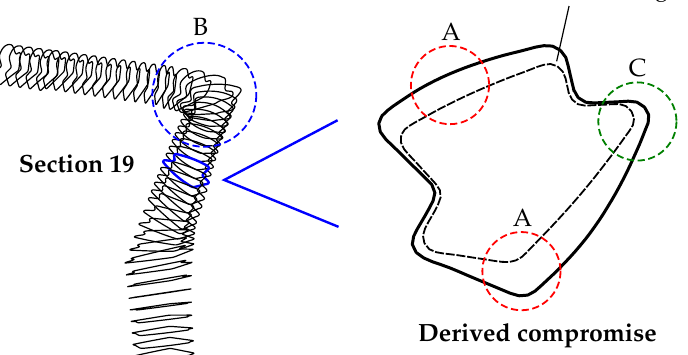
Figure 14. Illustration of the optimal compromise for the braided A-pillar.